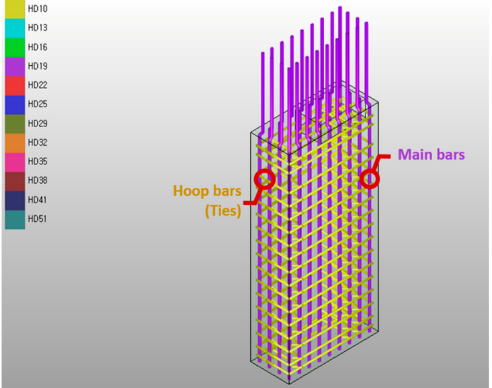
Figure 2. Example of the rebar arrangement of column members and the name of the rebar for each part (1F, Building #101 of construction project A).